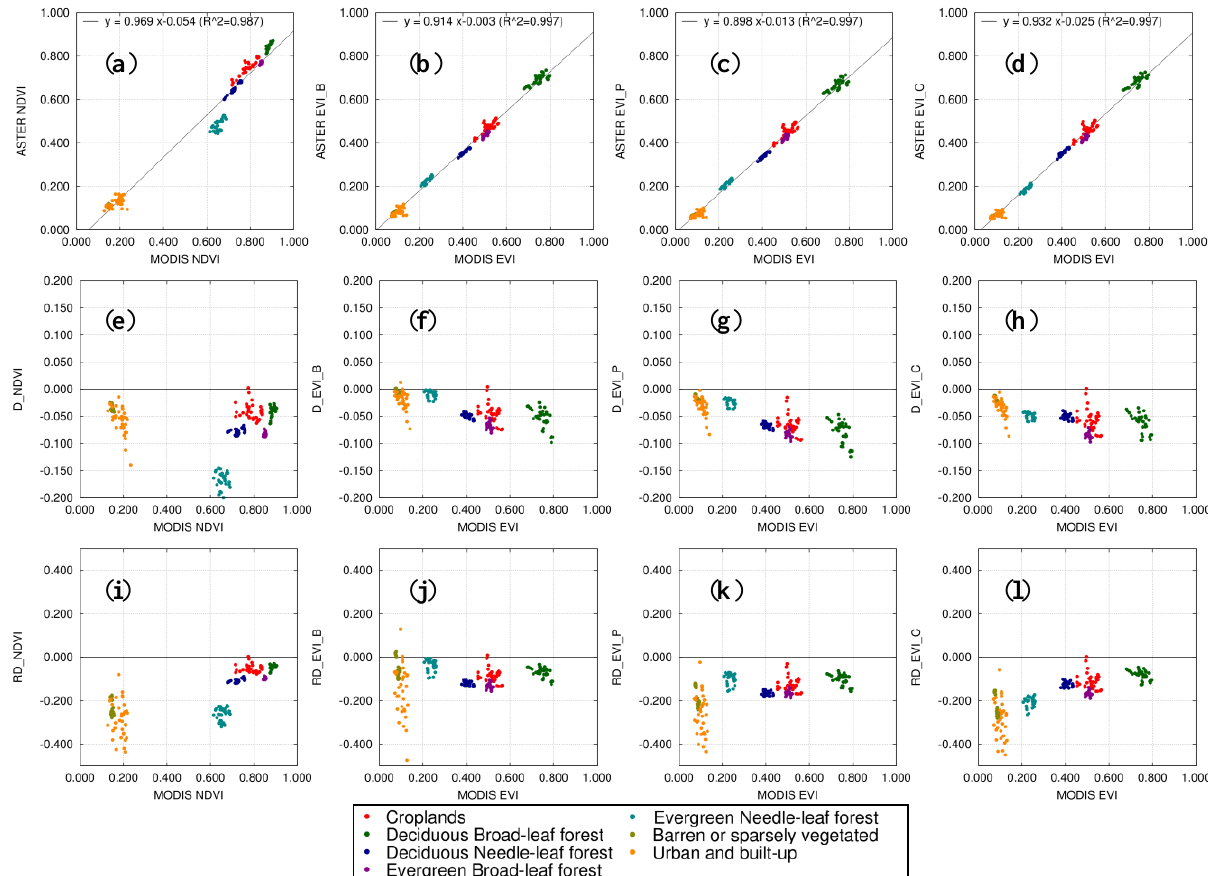
Figure 4. Scatterplots of MODIS vs. ASTER VIs with ASTER reflectances aggregated without MODIS PSF. ( a ) ASTER Normalized Difference Vegetation Index (NDVI) vs